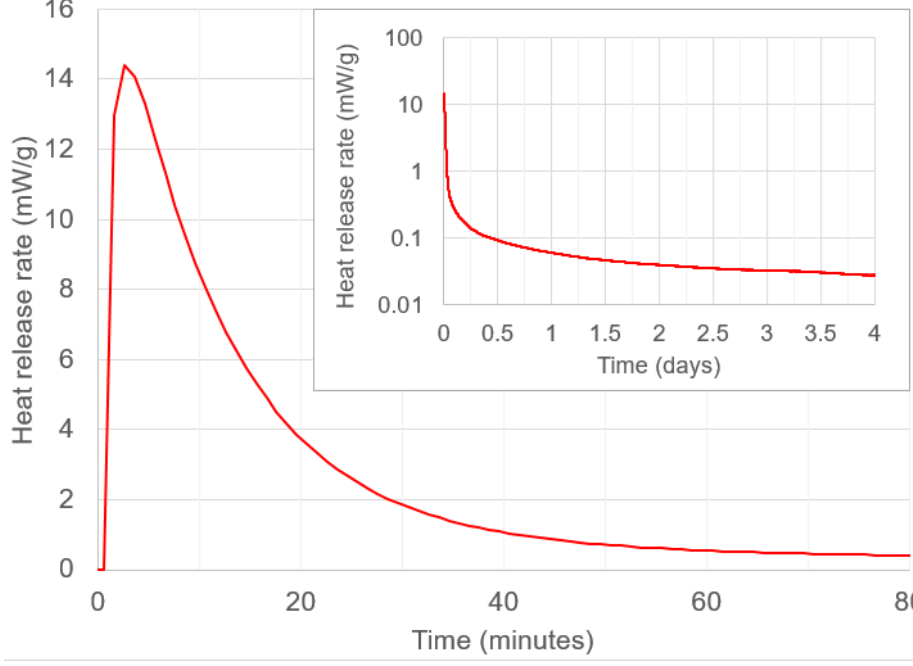
Figure 10. The rate of heat release of the geopolymer over the first 80 min and (inset) over 4 days on a logarithmic scale.